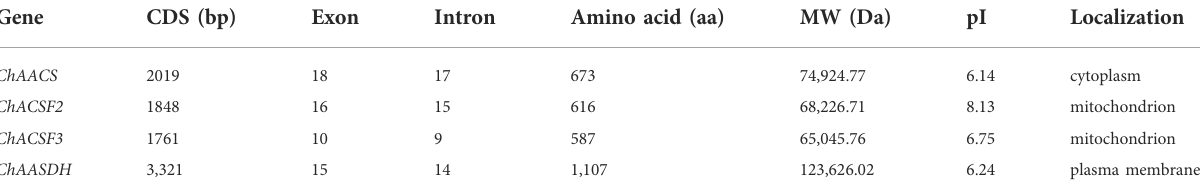
pI Localization acid (aa)